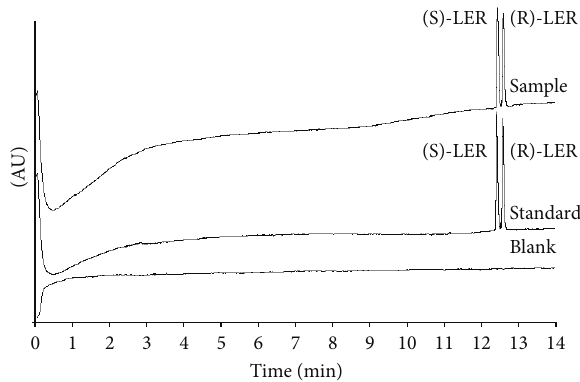
Figure5:Typicalelectropherogramsobtainedfollowingtheanalysis of Blank; a standard solution containing racemic LER and commer- cial tablets. Experimental conditions: fused-silica uncoated capillary 50 𝜇 m id and 50.0 cm effective length, +25kV, 200mmol/L sodium acetate buffer pH 4.0 (containing 10mmol/L of TM- 𝛽 -CD), and 15 ∘ C, 237 nm; injection: 10 seconds (at a pressure of 0.5